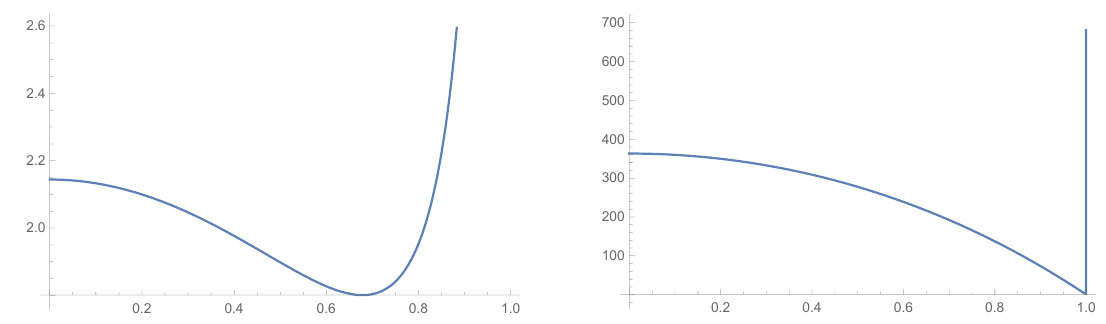
Figure 4 . Plots of the dilaton profile (3.16) for b = 5 (left) and b = 1000 (right). Larger b corresponds to higher temperature. The dilaton is minimized at the horizon, and its minimum value corresponds to the classical entropy of the black